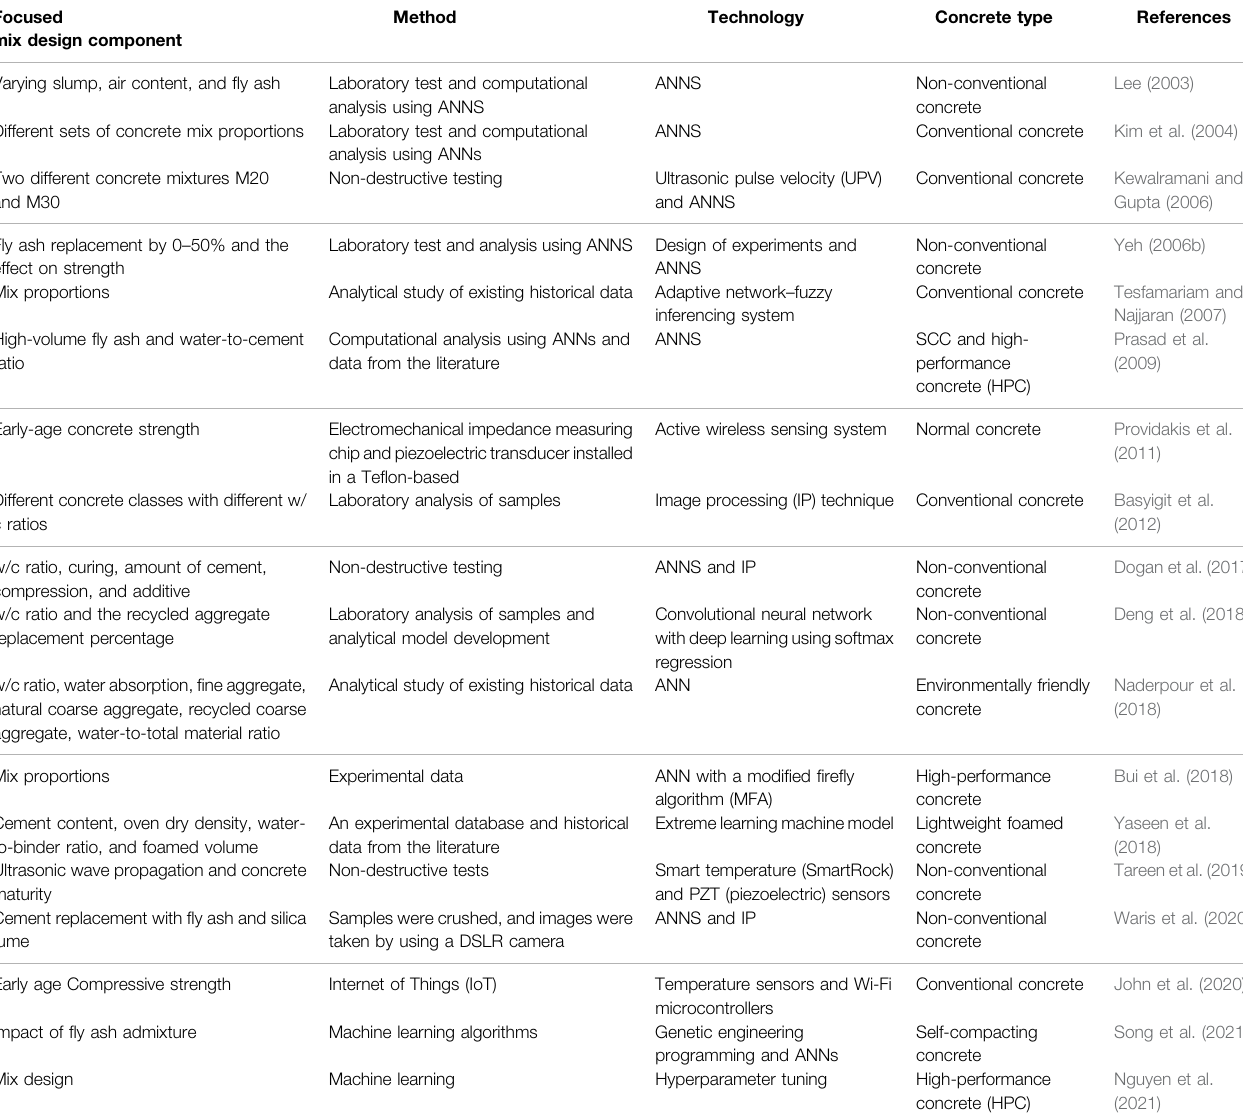
TABLE 6 | Digital transformation of the compressive strength of